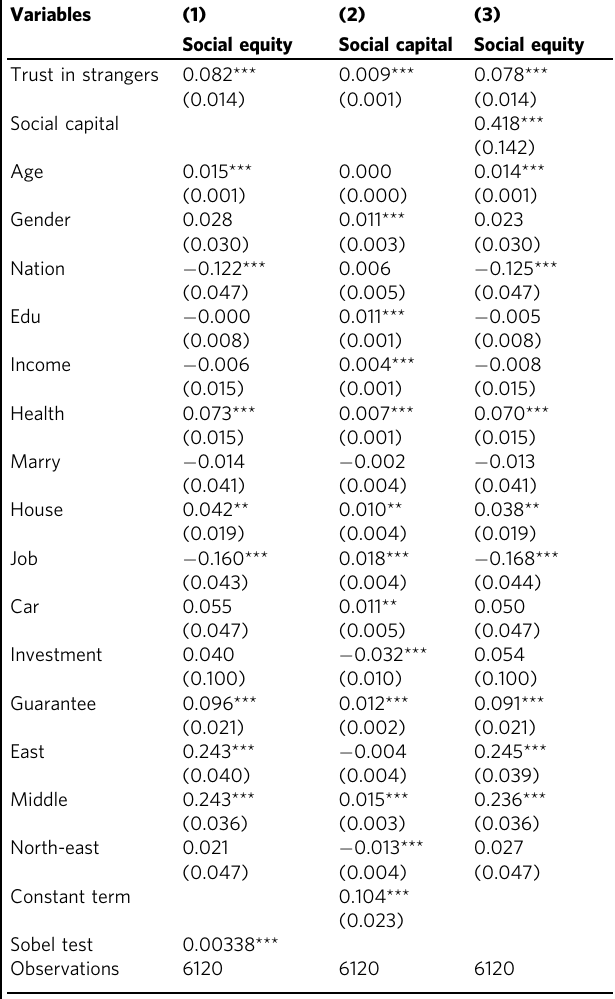
Table 6 Robustness test of social equity by trust and social